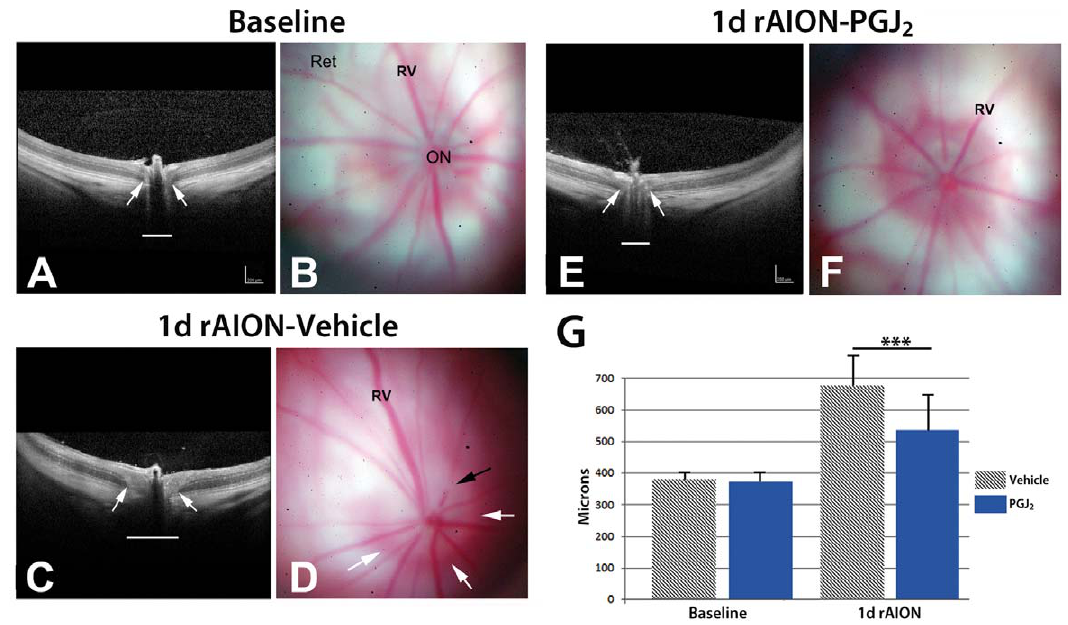
Figure 1. SD-OCT and retinal color photos of naı¨ve, and rAION-induced vehicle and PGJ 2 -treated eyes. A,B. Naı¨ve eye. By OCT, the retina is flat against the back of the eye. The ON shadow is narrow (arrows and white line). Retinal photo reveals the ON is flat against the retina, with no protrusion. Retinal veins (Rv) are of narrow caliber. C,D. rAION-vehicle treated. ON shows increased diameter by OCT analysis (arrows), compared with the naı¨ve eye (compare white line lengths). The retinal photo reveals a swollen and edematous ON (delineated by the white arrows). Crossing vessels are obscured in the edematous nerve (black arrow). E,F. rAION- PGJ 2 treatment. The ON shadow by OCT imaging is smaller, compared with the vehicle treated animal (Compare arrows and underlying diameter line in OCT photos of naı¨ve, and vehicle- and PGJ 2 -treated, rAION induced eyes). ON edema in PGJ 2 -treated animals is reduced in the color photo and is similar to the naı¨ve eye. Retinal veins (Rv) engorgement is reduced. G. SD-OCT quantification. The optic nerve diameter is equivalent in both naı¨ve and uninduced PGJ 2 -treated animals. One day post-induction, the ON diameter